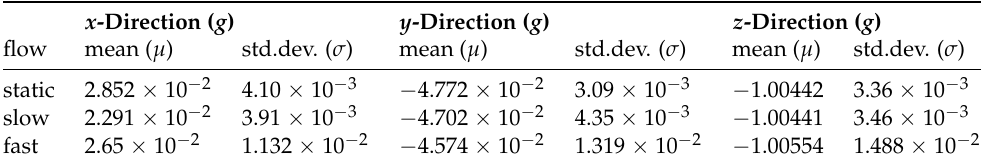
Table 2. Statistics (means, standard deviations) of three-axis accelerations of the rostrum during horizontal rostrum placement in three flows are calculated over 96,000 measurements encompassing the full duration of each of the five minute tests, respectively.